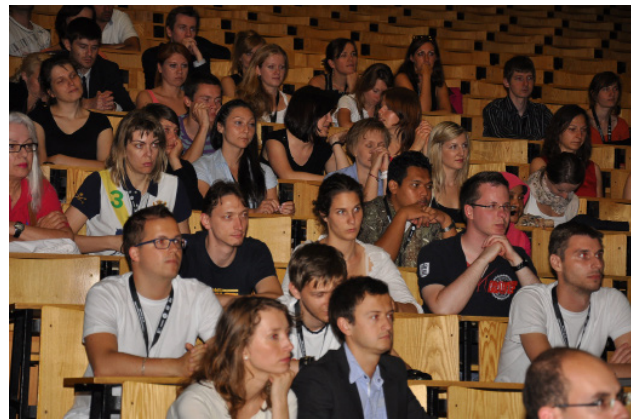
Figure 1. Auditorium view at the 4th International Student Medical Congress in Ko š